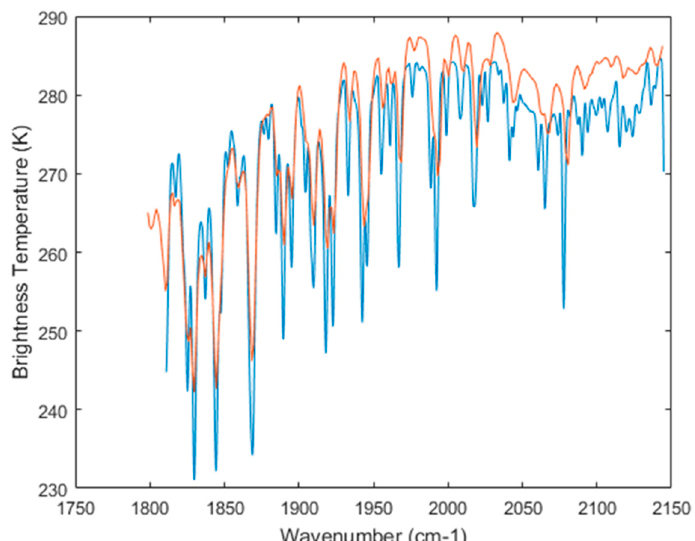
Figure A5. MWIR brightness temperature observed on 4 December over the cloud-clear ocean by the MISTiC airborne (red) instrument on the ER2 south of the Channel Islands, and the closest IASI-B (blue) nearly cloud-clear field observed from space approximately an hour earlier.